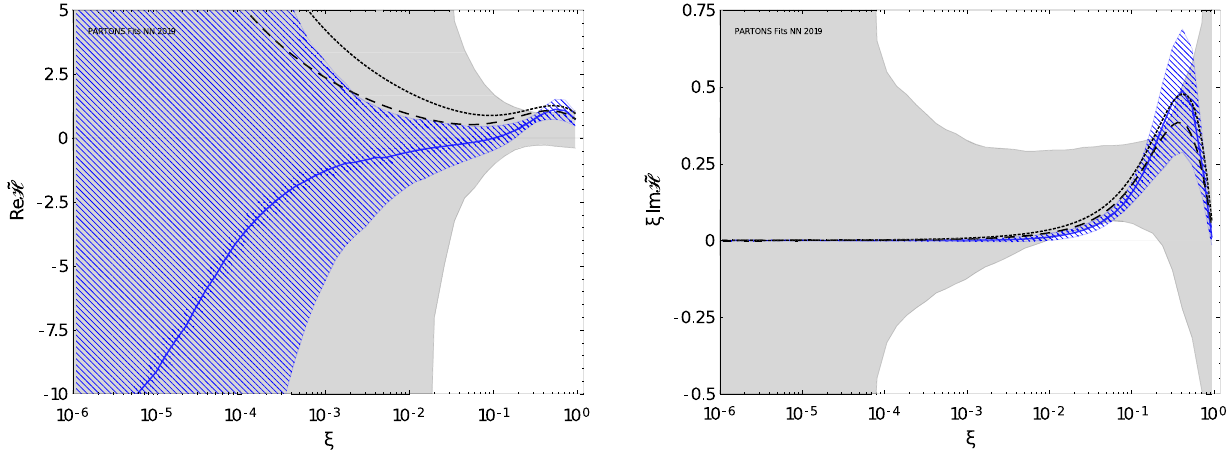
Fig. 17 Real (left) and imaginary (right) parts of the CFF (cid:2) H as a function of ξ for t = − 0 . 3 GeV 2 and Q 2 = 2 GeV 2 . For further description see the caption of Fig.